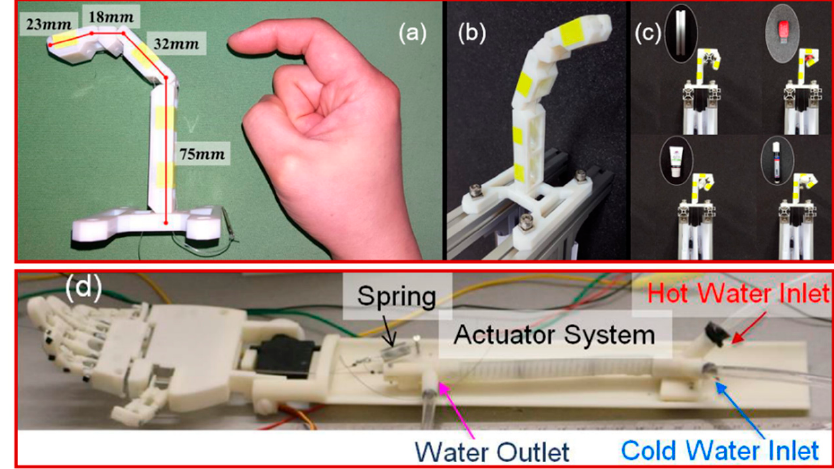
Figure 4. Tendon-driven biomimetic robotic finger: ( a , b ) the developed robotic finger and a human finger, and ( c ) grasping various objects (a cosmetic tube, a marker pen, a part of the aluminum profile and a USB flash drive, from left to right) (Reprinted (adapted) with permission [86] . Copyright (2016) SPIE. Digital Library). ( d ) Finger configuration in a prototype hand in the actuation system housed in the forearm and tendons connected to the fingers (Reprinted (adapted) with permission [87] .